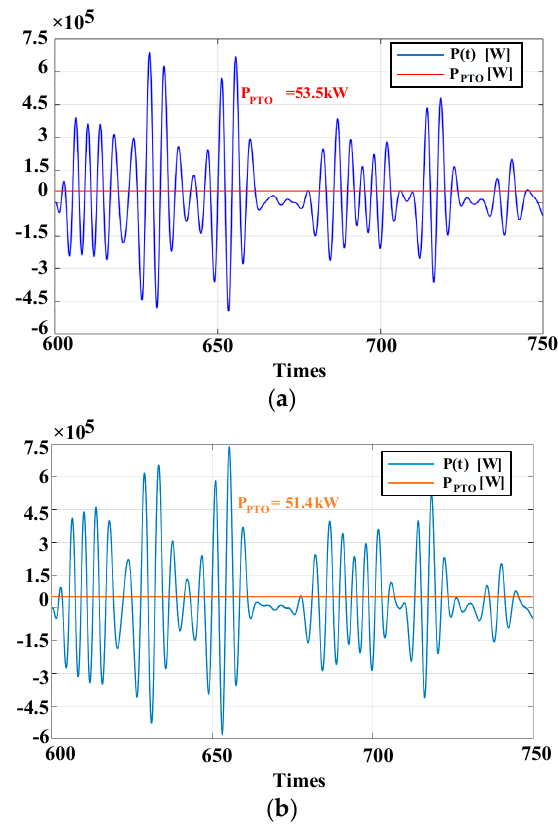
Figure 10. Simulated instantaneous and average power obtained by ( a ) FPA and ( b ) hill-climbing